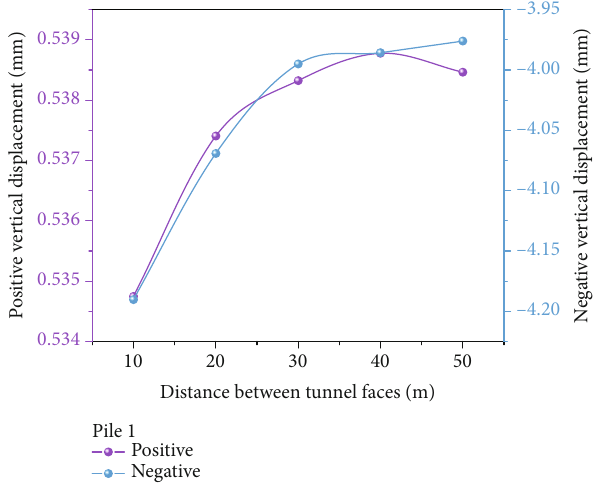
Figure 18: Maximum vertical displacements of Pile 1 on completion of twin tunneling at di ff erent tunnel face-to-face distances.